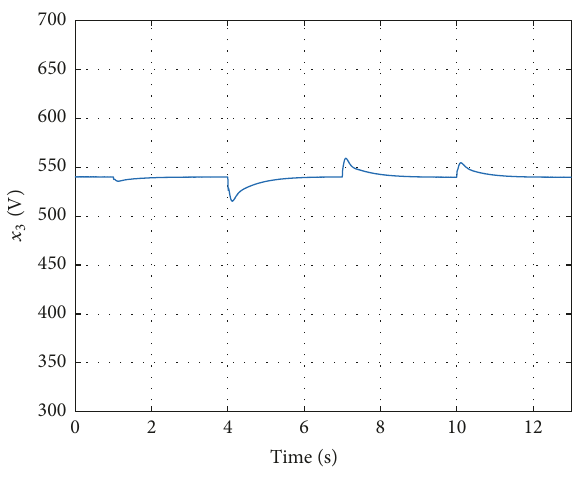
Figure 11: Bus voltage.